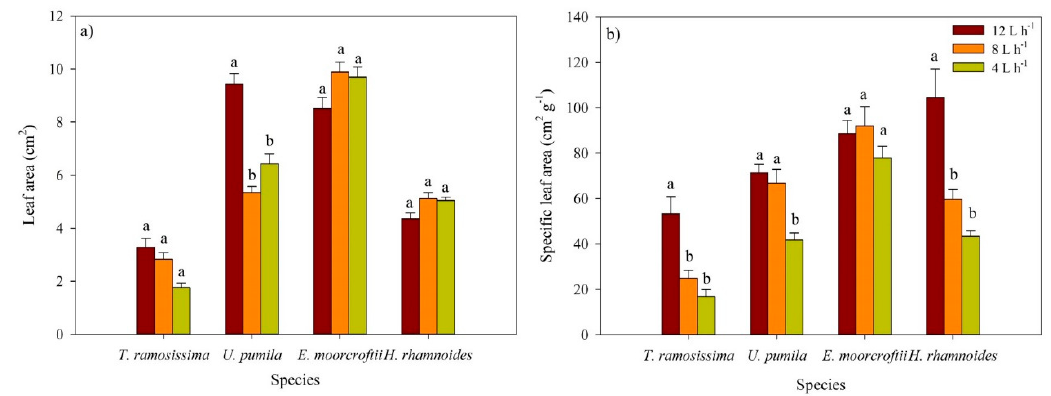
Figure 6. ( a ) Leaf area (LA) and ( b ) specific leaf area (SLA) of Tamarix ramosissima , Ulmus pumila , Elaeagnus moorcroftii , and Hippophae rhamnoides across different irrigation treatments (12, 8, 4 L h − 1 ) measured in July 2016. Different lowercase letters within each species indicate significant differences among the treatments at α = 0.05. Vertical bars represent standard errors.